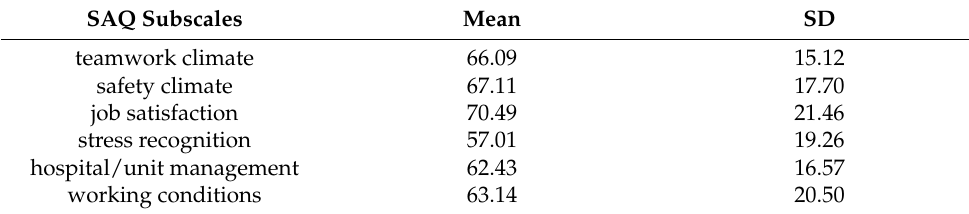
Table 3. Attitude of nurses regarding patient safety (SAQ).